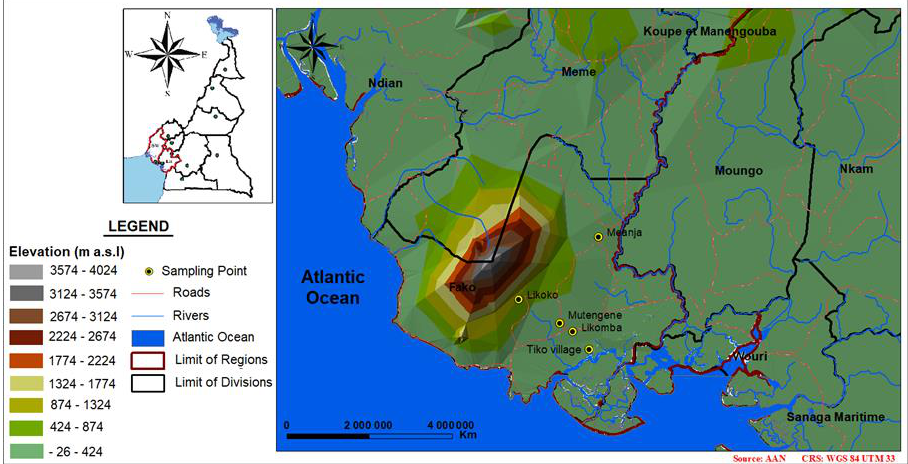
Figure 1. Map of the study area.